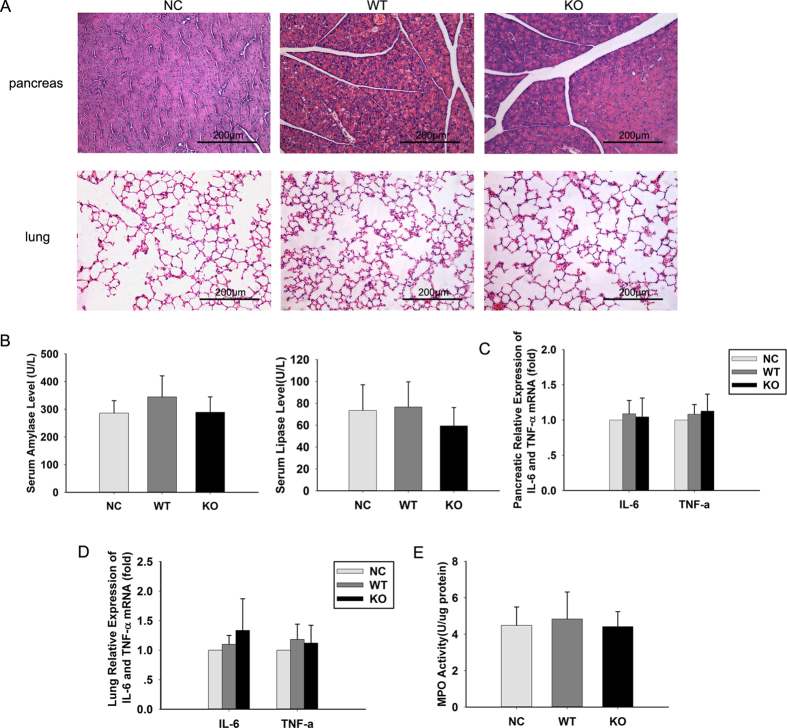
Single use of LPS was not able to induce pancreatic and lung damage in mice.(A) Representative micrographs of pancreas and lung showed that single use of LPS was not able to induce pancreatic and lung damage. Activities of serum amylase and lipase (B), the mRNA levels of IL-6 and TNF-α in pancreatic tissues (C) or lung tissues (D) and pulmonary MPO activity (E) indicate single use of LPS is not able to induce pancreatic or pulmonary injury in both wild-type and JAM-C knockout mice. NC: normal control (n = 4), WT: wild-type mice (n = 7), KO: JAM-C knockout mice (n = 7). Original magnification ×200. The mice were sacrificed 2 h after the LPS injection.